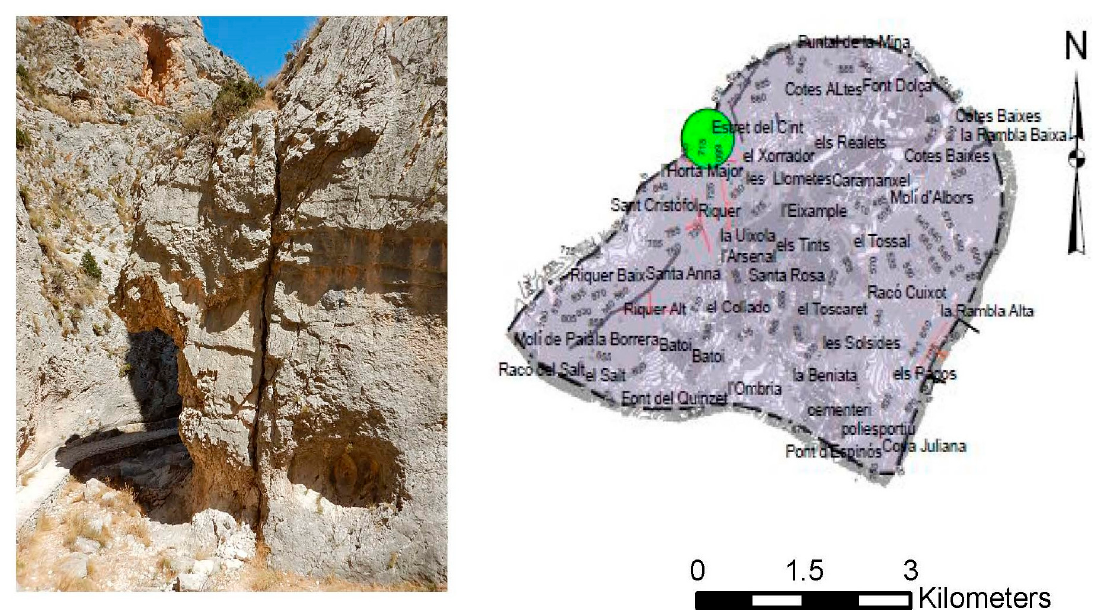
Figure 4. Example of jointed rock-mass outcropping in the Estret del Cint locality.